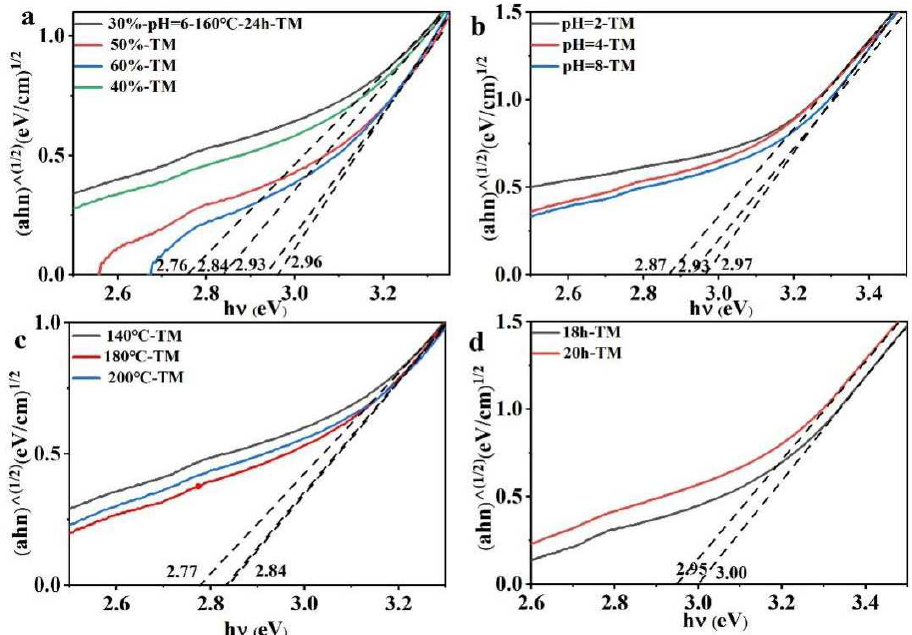
Figure 14. Tauc plots of TiO 2 -montmorillonite (MMT) composites prepared using ( a ) different TiO 2 /MMT mass ratios at a reaction temperature of 160 ◦ C, a dwelling time of 24 h, and a pH of 6; ( b ) different pH values at a reaction temperature of 160 ◦ C, a dwelling time of 24 h, and a TiO 2 mass ratio of 30 wt%; ( c ) different reaction temperatures with a dwelling time of 24 h, a pH of 6, and a TiO 2 content of 30 wt%; and ( d ) different dwelling times at a reaction temperature of 160 ◦ C, a pH of 6, and a TiO 2 mass ratio of 30 wt%.